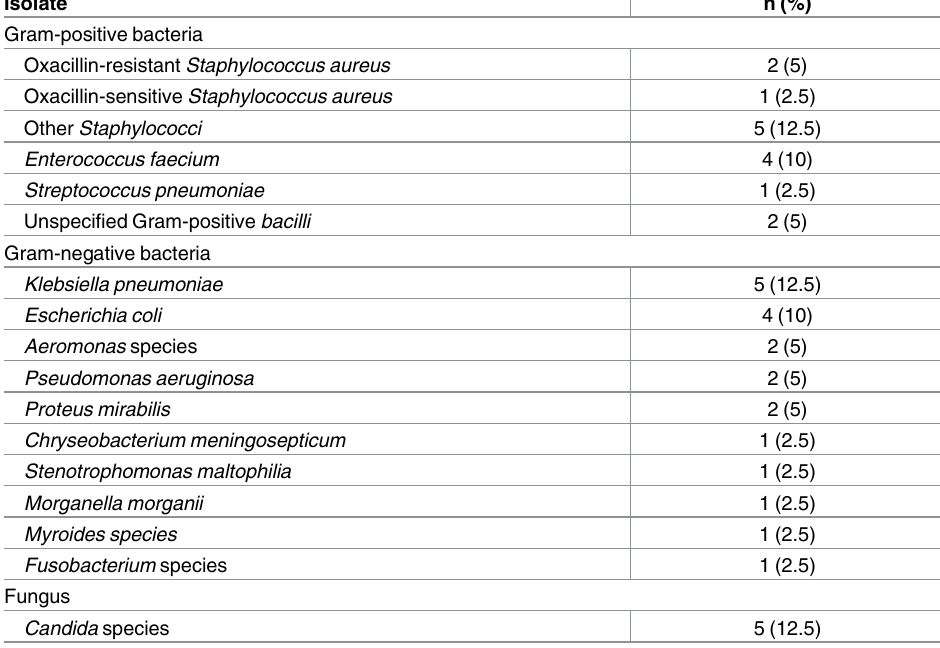
Table 2. Microorganisms isolated from blood cultures of patients with severesepsis and septic shock.